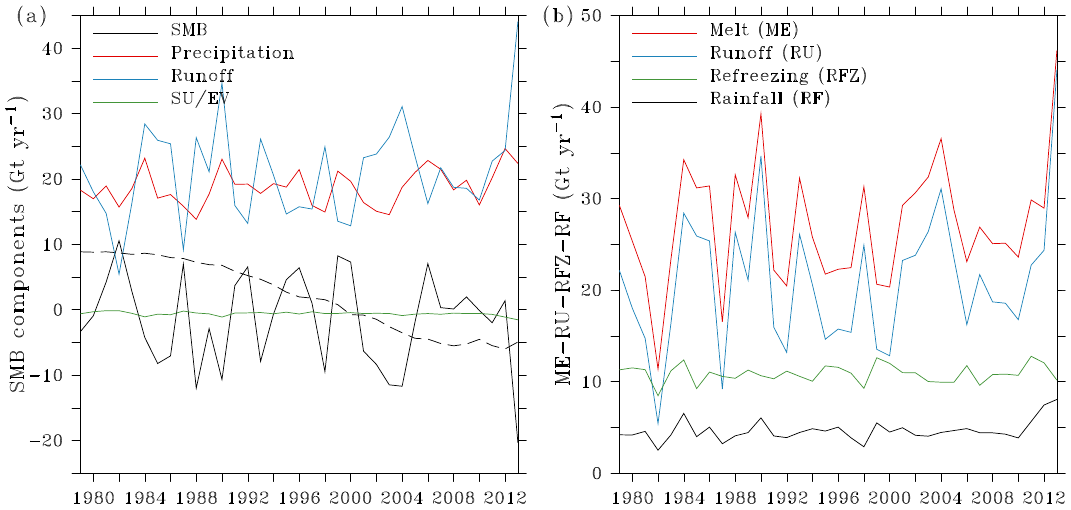
Figure 3. (a) Evolution of the MAR ERA -based SMB integrated over the permanent ice mask (Gtyr − 1 ) and its components: (solid plus liquid) precipitation, meltwater runoff and sublimation and evaporation (SU/EV) over 1979–2013. The dashed black curve represents the MAR MIROC5 -based SMB (after having applied a 10yr running mean). (b) Same as (a) but for the liquid water (melt, runoff and liquid precipitation) and refreezing (Gtyr − 1 ). Table 8. Comparison between SMB simulated by MAR (mmw . e . yr − 1 ) and different studies. (1) The SMB estimate has been calculated as